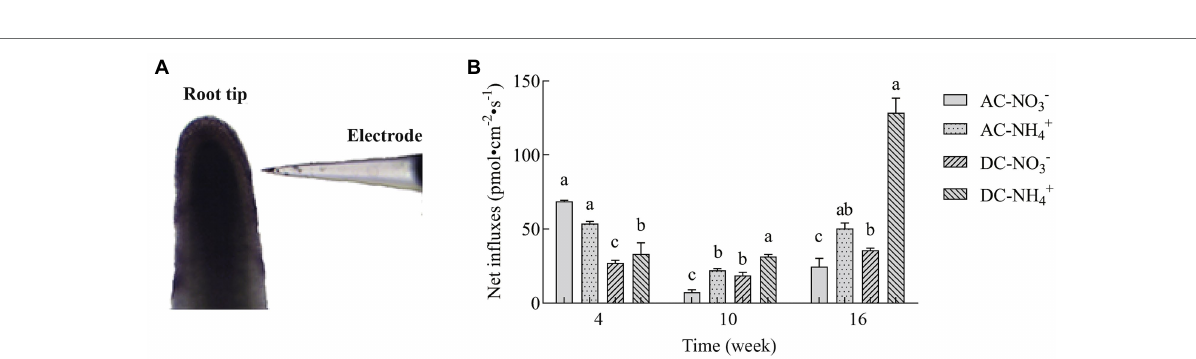
FIGURE 4 | Net influxes of NO 3 − and NH 4 + in D. officinale ( n = 6). (A) Detected image. (B) Effects of fungus MF23 on net NO 3 − and NH 4 + influxes in D. officinale ( n = 6). AC, axenic culture and DC, dual culture. The Y-axis represents the maximal net NH differences between